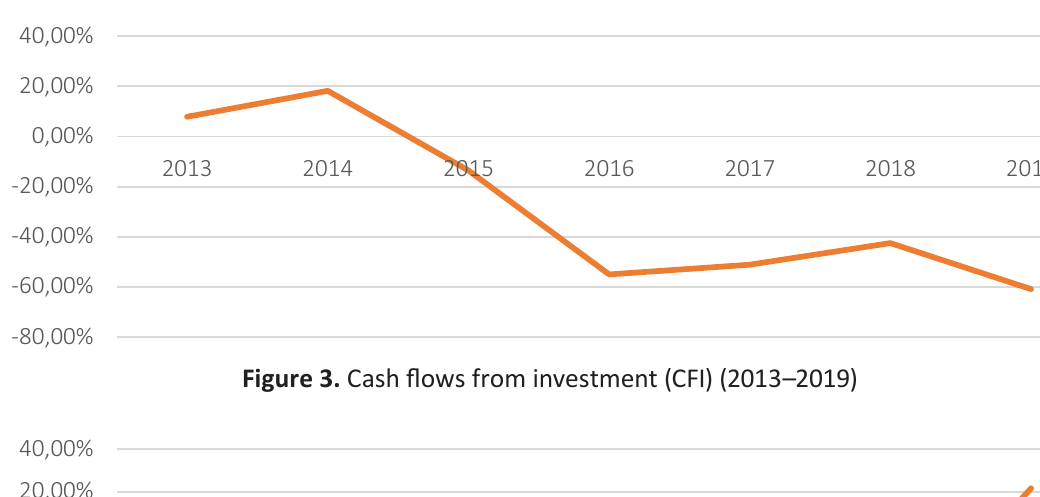
Figure 2. Cash flows from operations (CFO) (2013–2019)